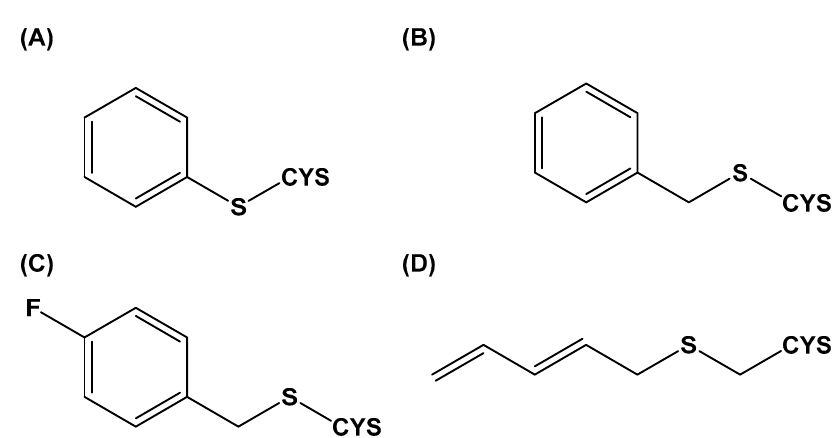
Figure 5. Synthetic thioallyl derivatives described in the work of Pinto [77]. ( A ) Phenyl-S-cysteine, ( B ) benzyl-S-cysteine, ( C ) para -fluorobenzyl- S -cysteine, and ( D ) penta-1,3-dienyl- S -cysteine. In the last decade, one of the most widely characterized cysteine analogs is S -propylargyl cysteine (SPRC; Figure 6) identified after an initial screening of several analogs of S -allylcysteine [78,79].